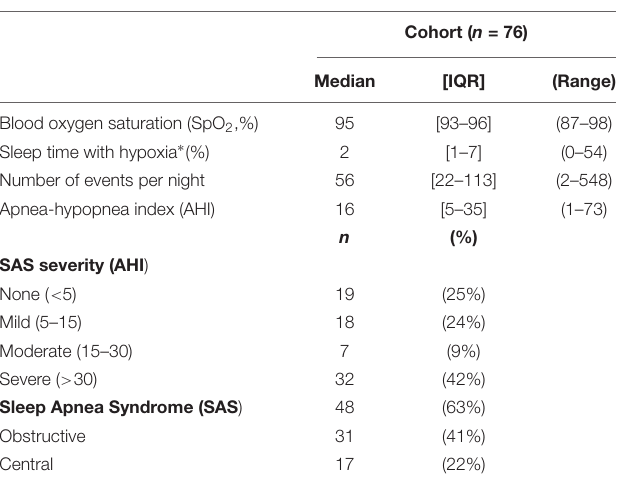
TABLE 2 | Sleep Apnea Syndrome.